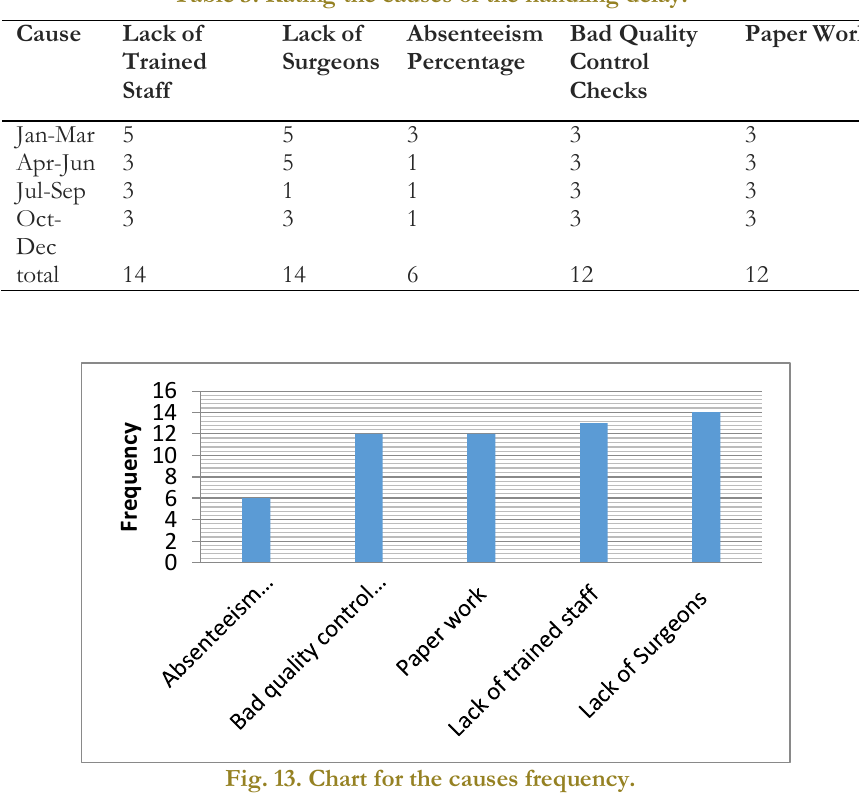
Table 3. Rating the causes of the handling delay.